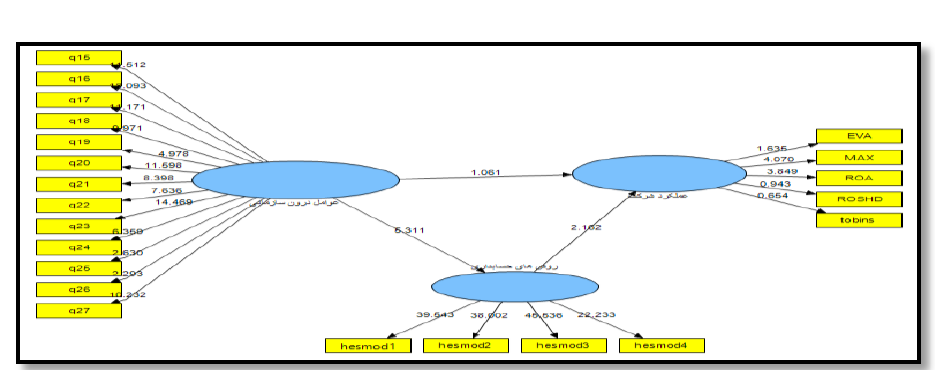
Figure 6. t-statistic for studying the significance of path coefficient